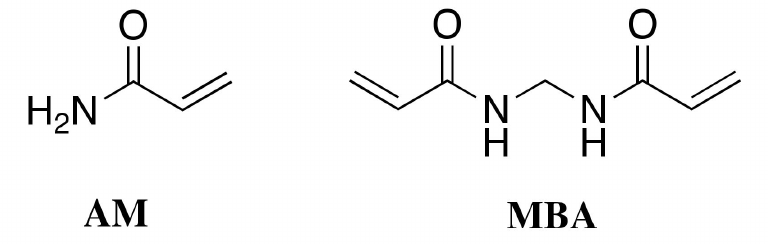
Figure 10. Chemical structure of acrylamide (AM) and N,N (cid:48) -methylenebisacrylamide (MBA). Repro- duced with permission from reference